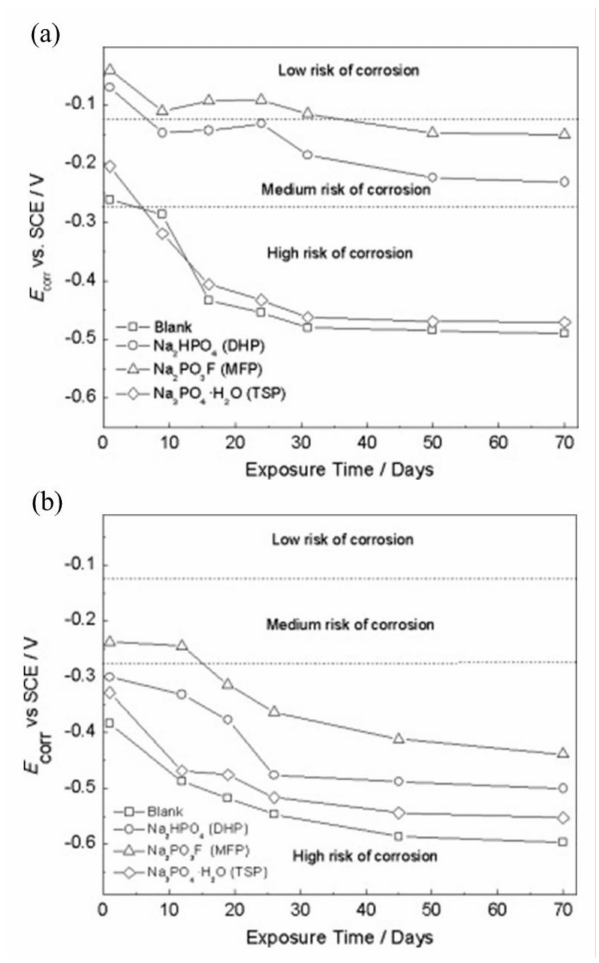
Figure 16. Corrosion potential ( E corr ) versus time for steel in the presence of: ( a ) migrating corrosion inhibitor (MCI) and ( b ) admixture corrosion inhibitor (ACI) bottom and in contact with 3.5 wt.% NaCl [46]. Reproduced with permission from Bastidas, D.M. et al., Cem. Conc. Comp.; published by Elsevier,